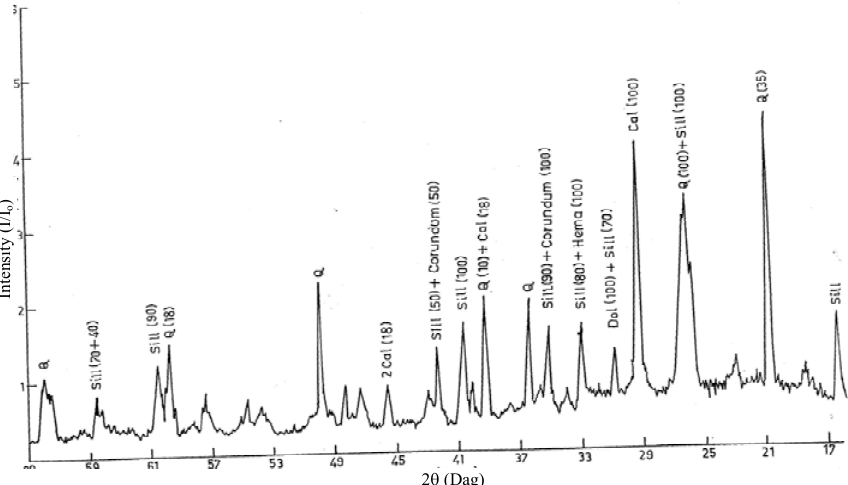
Figure 5. XRD pattern of steam cured LFAS Cube containing nickel hydroxide sludge